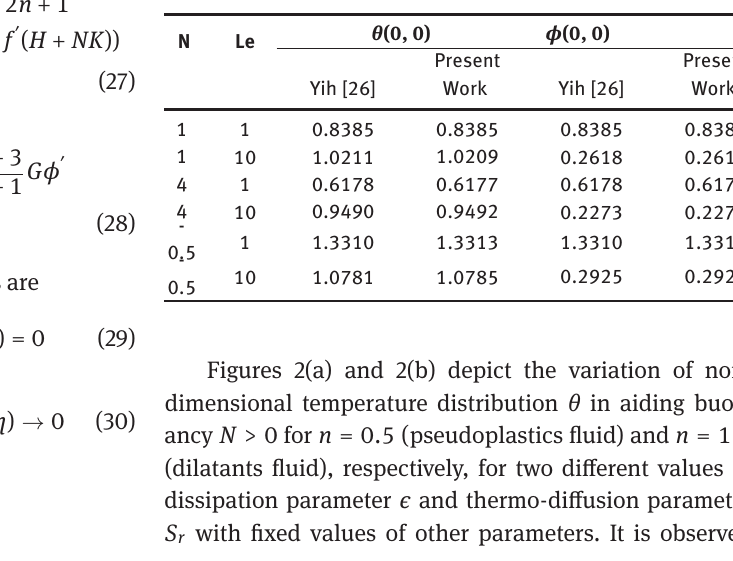
Table 2: Comparison of θ (0, 0) and ϕ (0, 0) with previously pub- lished article of Yih [26] for free convection flow of Newtonian fluid over a vertical cone in a saturated porous